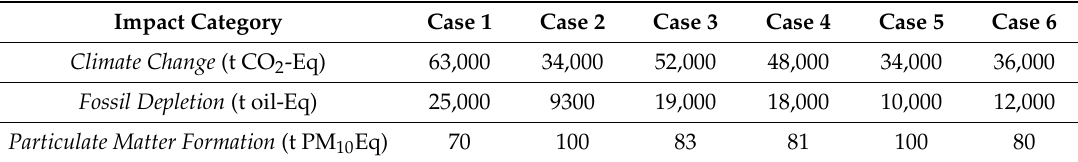
Figure 3. Sensitivity analysis of the six scenarios defined for the energy mixes of DP1. The scenario with the highest impact was taken as 100% and the rest of the scenarios are relative to it. Table 7. Impact of the scenarios on the mid-point categories climate change, fossil depletion, and particulate matter formation.